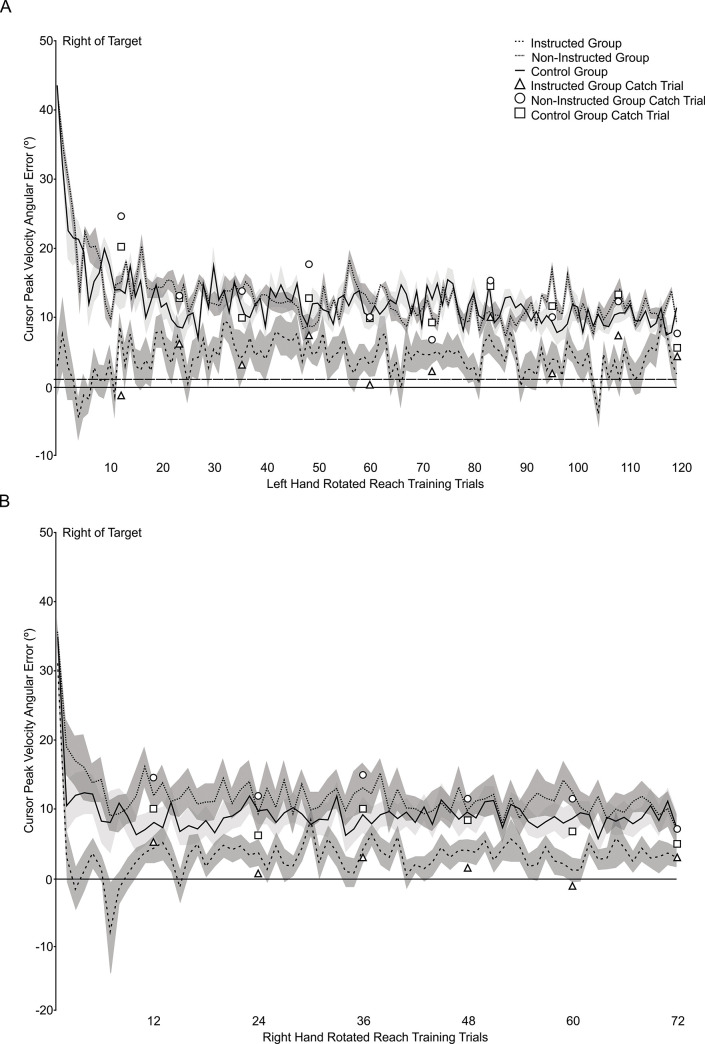
Average reaching errors across rotated reach training trials with the (A) left (trained) and (B) right (untrained) hands. Average cursor directional errors when reaching with the left (A: Block 3, Day 1) and right (B: Block 2, Day 2) hands during rotated reach training. The dashed, dotted, and solid lines represent average reach direction errors for the Instructed, Non-Instructed, and Control groups across rotated reach training trials, respectively. For all groups, the shaded region surrounding each line represents the standard error of the group mean. The triangle, circle, and square symbols represent average errors on catch trials, when no cursor was displayed for the Instructed, Non-Instructed and Control groups, respectively. In (A), the dashed straight line represents the average cursor directional error during aligned reach training trials across all participants. Positive cursor PV angular errors indicate the cursor position was to the right of the target, while negative cursor PV angular errors indicate the cursor position was to the left of the target.